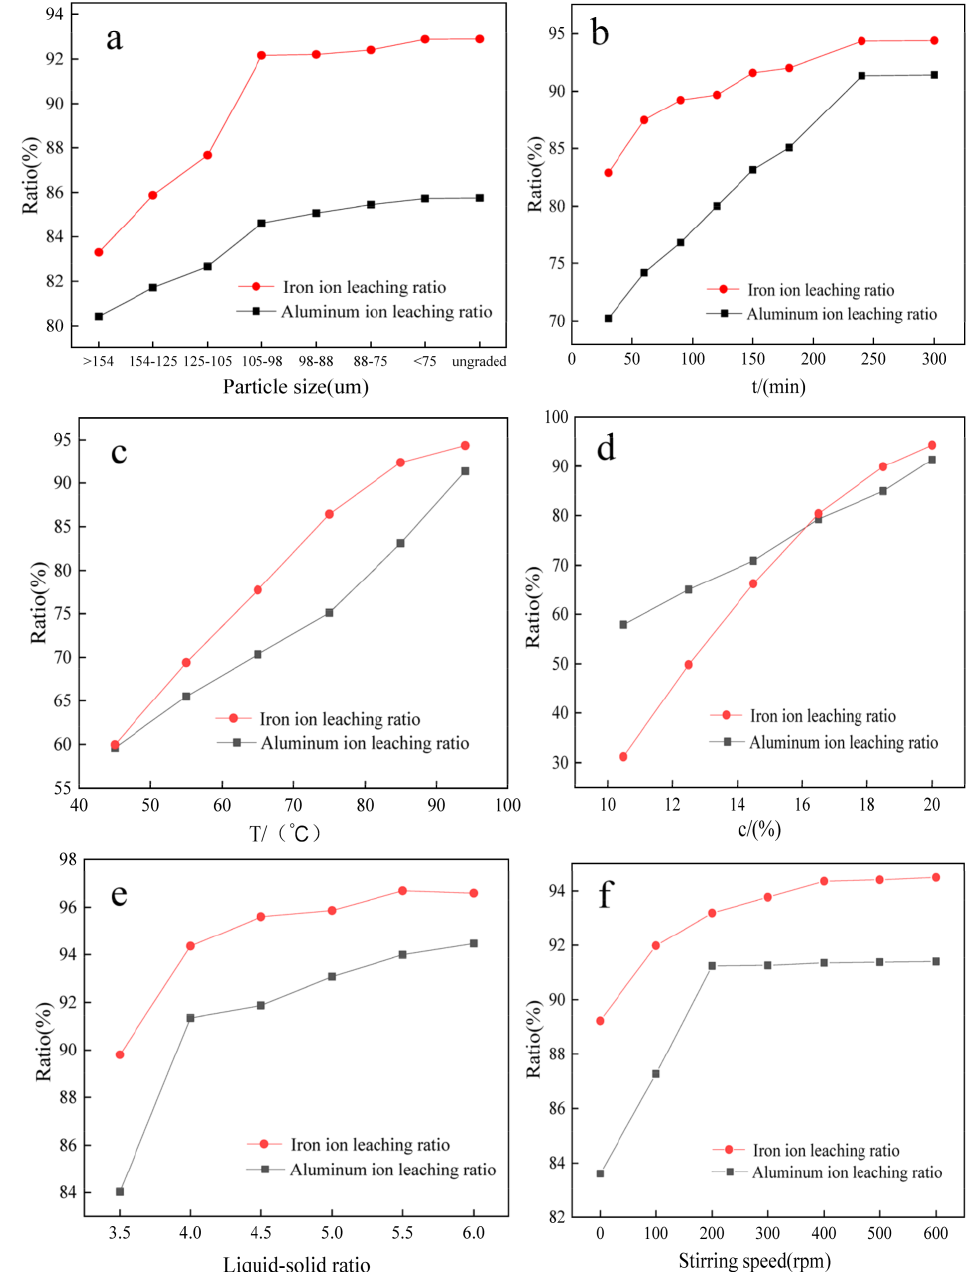
Figure 6. Effect of other process conditions on the leaching ratios of aluminum and iron ions. ( a ) is the relationship between particle size and leaching ratio, ( b ) is the relationship between acid leaching time and leaching ratio, ( c ) is the relationship between acid leaching temperature and leaching ratio, ( d ) is the relationship between hydrochloric acid concentration and leaching ratio, ( e ) is the relationship between liquid-solid ratio and leaching ratio, and ( f ) is the relationship between stirring speed and leaching ratio.